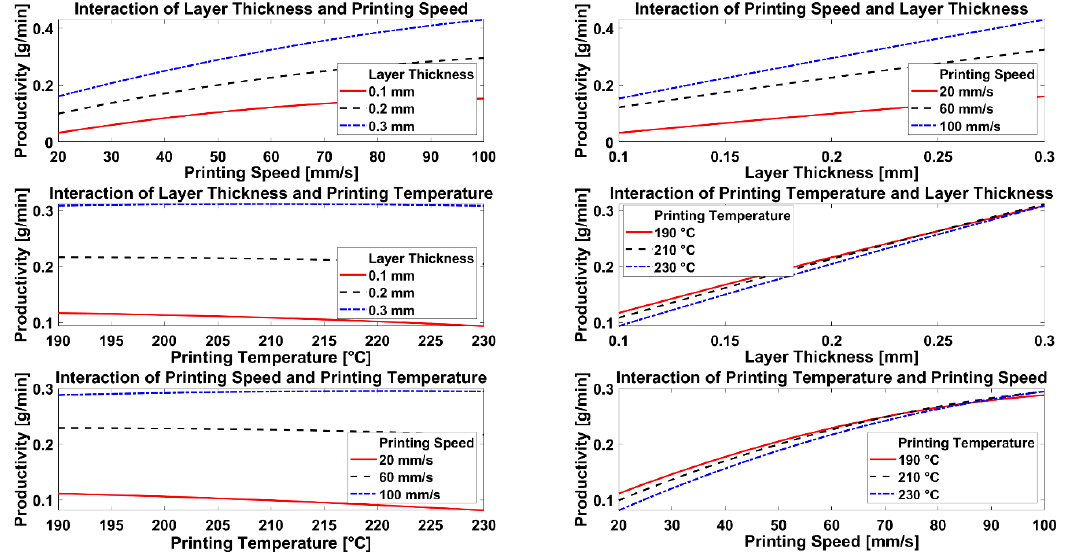
Figure 16. Effects of interaction of parameters on measured productivity. Figure 16. E ff ects of interaction of parameters on measured